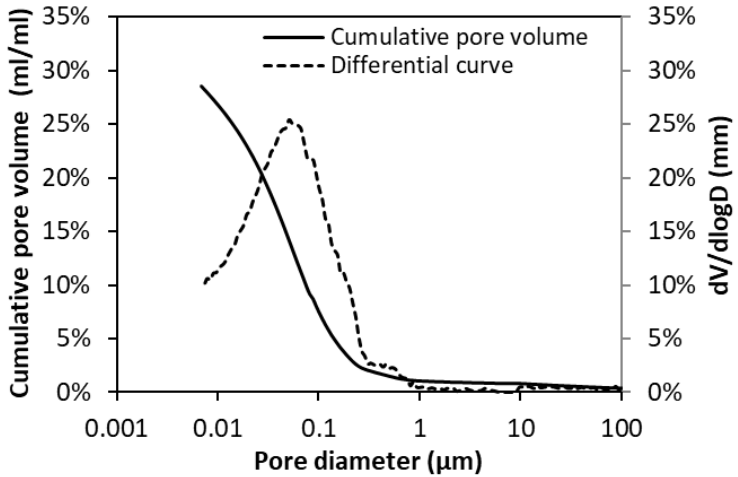
Figure 4. Pore size distribution of cement paste (OPC, 28 d, w/b = 0.5) measured by mercury intrusion porosimetry (MIP).